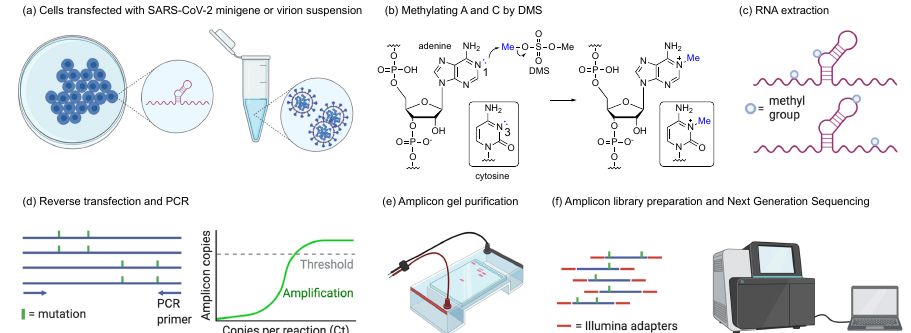
Figure A1. The workflow of DMS-MaPseq in this study. ( a ) BSR T5/7 cells were transfected with SARS-CoV-2 minigene for in vivo DMS-MaPseq. Infectious virions were collected for in-virion DMS-MaPseq. ( b ) Adenines and cytosines in the unpaired region of the transcriptome have a higher probability to be methylated by DMS. ( c ) The DMS-modified RNA was extracted. ( d ) The A- or C-methylated RNA can induce single-point mutations at the methylated nucleobase during the reverse transcription. Amplicons of 895 and 1291 base pairs were amplified by PCR for in-virion and in vivo minigene DMS-MaPseqs, respectively. ( e ) The band was purified by agarose gel electrophoresis. ( f ) The amplicons were ligated with Illumina sequencing adapters and sequenced in at a paired-end mode (150 bp × 2). ( a , e , f ) are generated by BioRender.com.